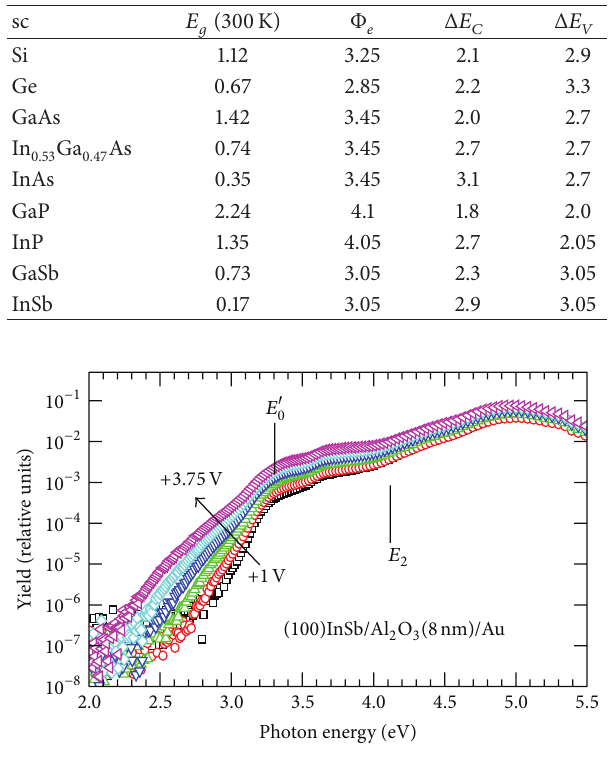
Figure 32: Semilogarithmic plot of the IPE quantum yield as a func- tion of photon energy as measured on (100)InSb/a-Al 2 O 3 (8nm)/Au sample with the applied bias varying from 1V to 3.75 V. The vertical arrows 𝐸 0 and 𝐸 2 mark the energy of direct optical transitions in the InSb